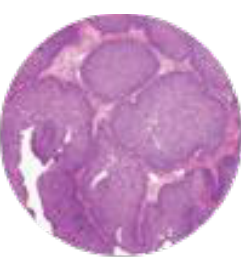
Figure 7. Hematoxylin and eosin staining of an inverted papilloma demonstrating ribbons of hyperplastic respiratory epithelium that grow into the adjacent stroma.